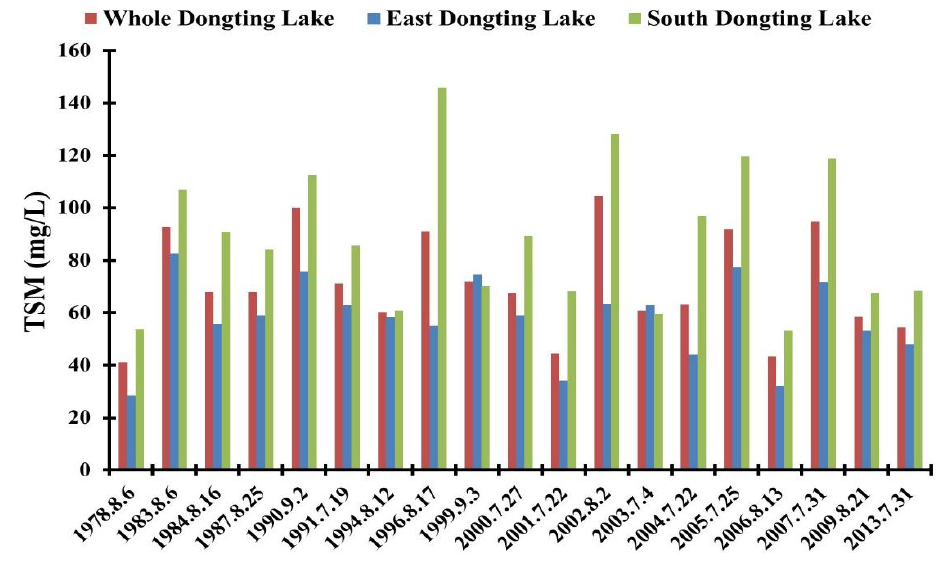
Figure 5. Derived mean TSM for WDL and two sub-regions of EDL and SDL in the wet season, from 1978 to 2013. WDL is the Whole Dongting Lake, EDL is the East Dongting Lake, and SDL is the South Dongting